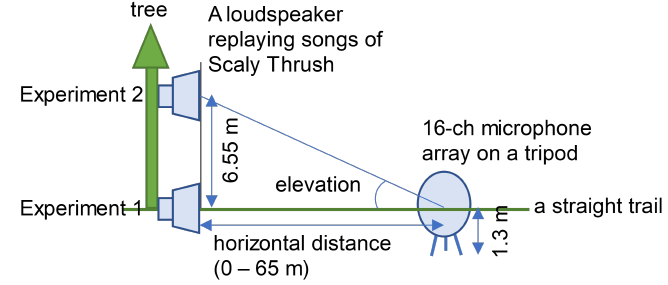
Figure 2. A schematic image of the experimental condition.